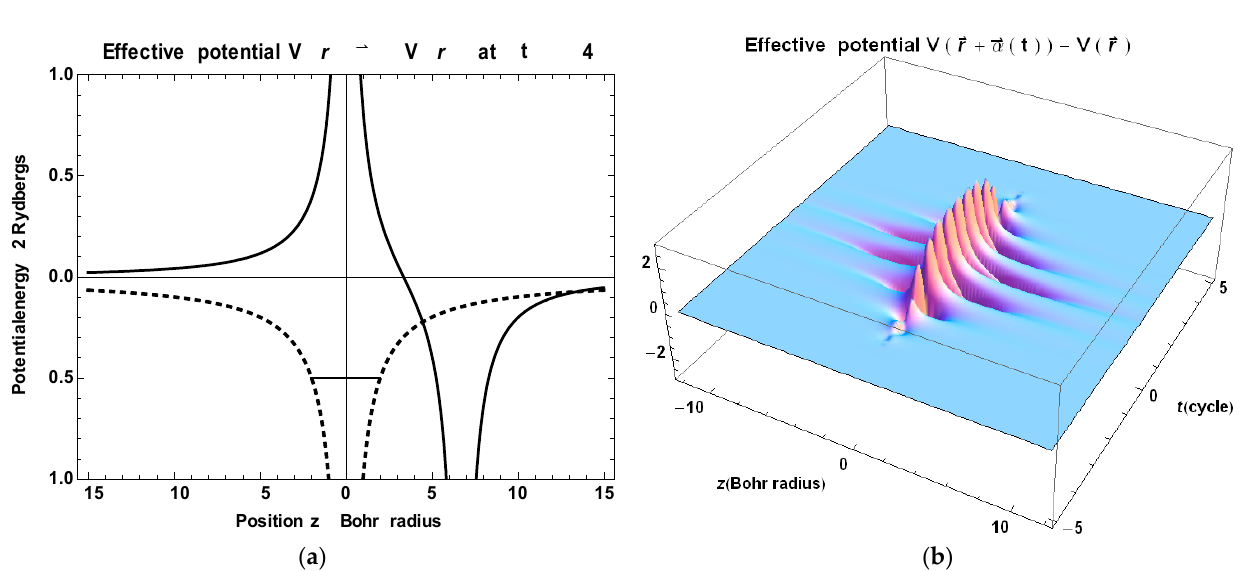
Figure 1. This figure shows the multiphoton effective potential V ˆ α = V ( r + α ) − V ( r ) , given by Equation (34), for V ( r ) = − e 2 / r , in the semi-classical limit, where ˆ α is replaced by a c-number α ( t ) (see Equation (A47) in Appendix B): ( a ) the continuous line is the effective potential along the polarization direction, and the dashed line represent the original Coulomb potential. By using (A47), we have taken λ = 0.8 × 10 − 4 cm, and I = 3 × 10 13 W/cm 2 , in which case the amplitude of the free electron oscillation (or Hertz potential) is 9 times larger than the Bohr radius ( a 0 = (cid:125) 2 / me 2 = 5 × 10 − 9 cm). We have taken the value ρ = 0.001 for the cylindrical coordinate; ( b ) this 3D figure illustrates the temporal evolution of the effective potential in Heisenberg picture. We have taken one quarter of the former intensity and assumed a Gaussian envelope exp ( − t 2 /2 ) , which corresponds to 2.3 cyles full temporal width at half maximum. For a better visualization, we have chosen ρ = 0.32 for the cylindrical coordinate. This figure illustrates, that the effective potential vanishes before and after the external pulse, in contrast to the usual Kramers-Henneberger space translated potential V ( r + α ( t ))